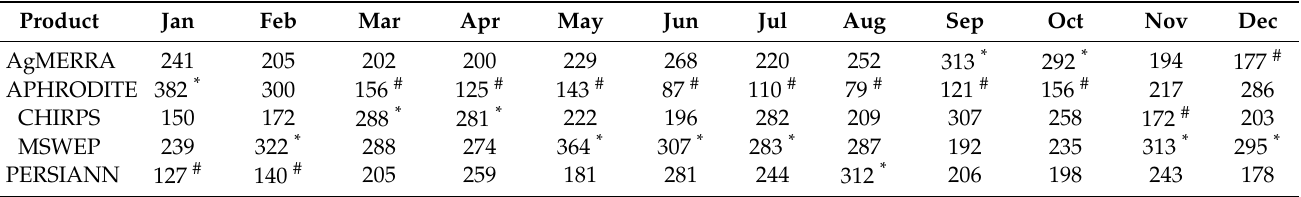
Table 3. The number of grid points over the whole basin that had the smallest ME compared with the IDW-interpolated precipitation at a monthly scale.